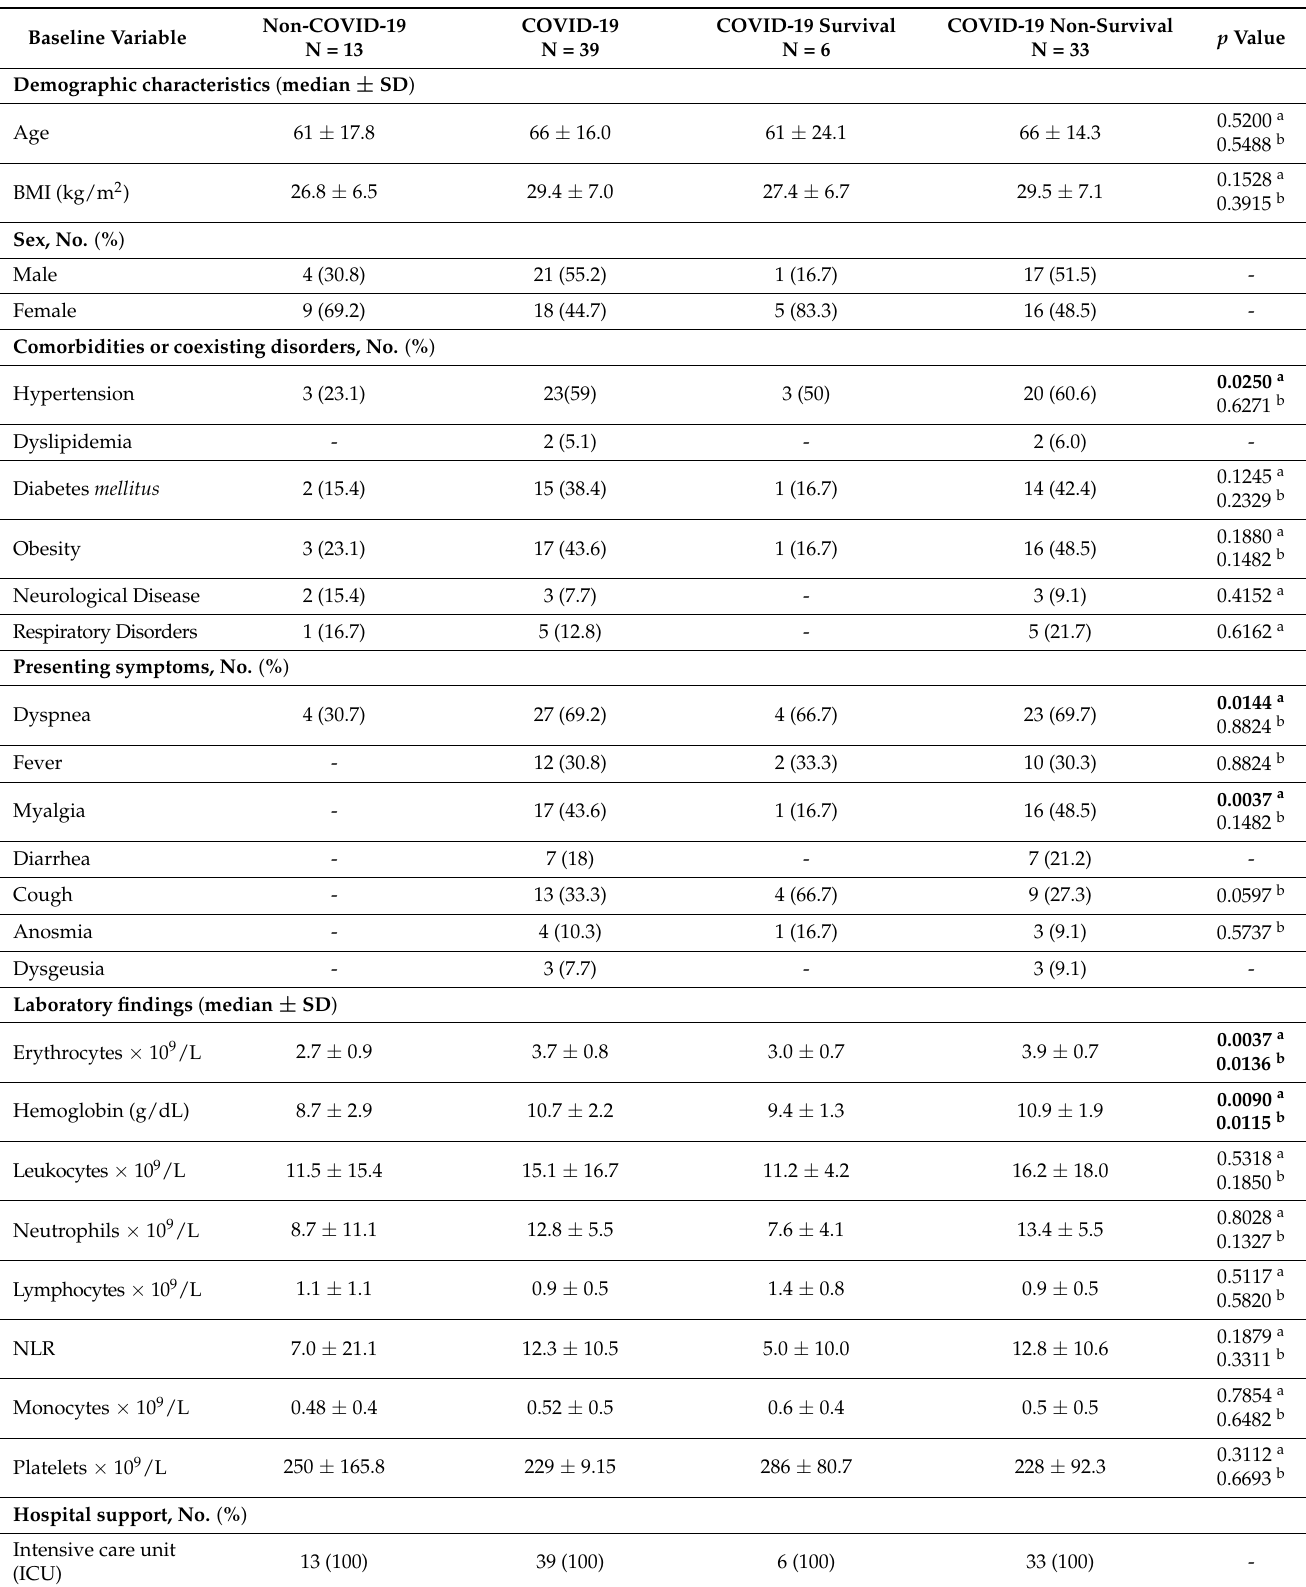
Table 1. Participants clinical and demographic data enrolled in this